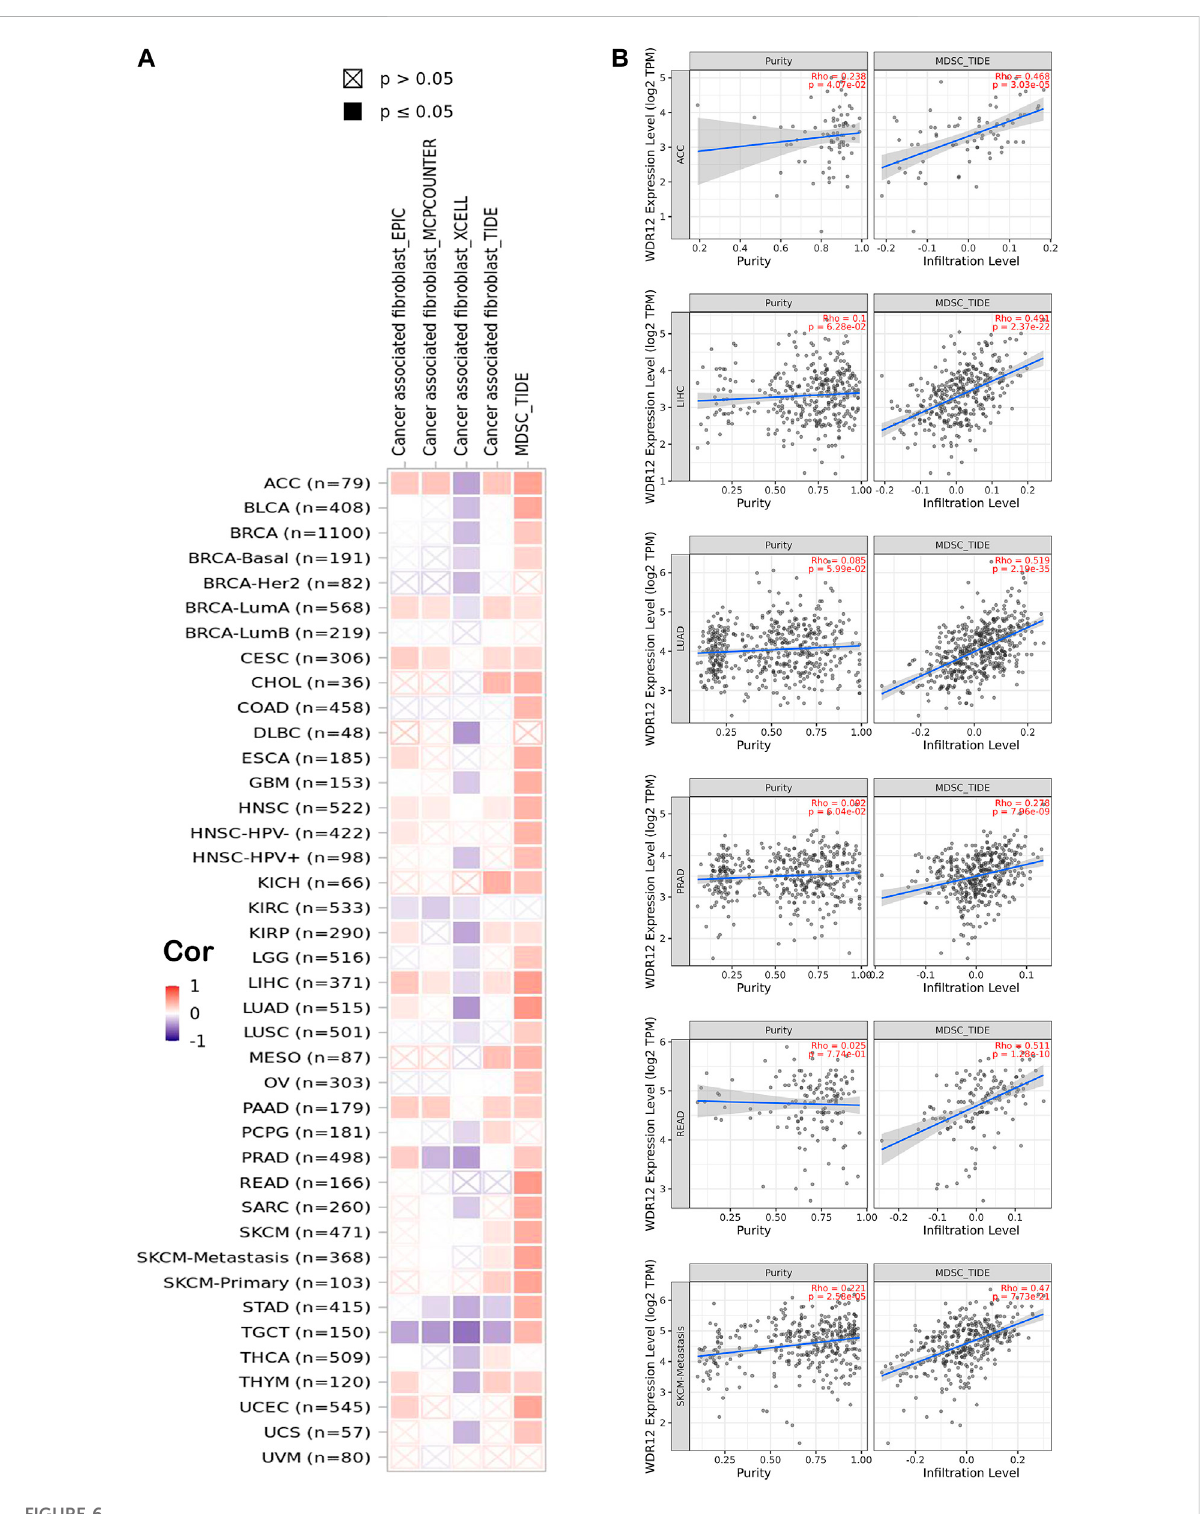
FIGURE 6 Correlation betweenWDR12expression leveland in fi ltrationof (A) myeloid-derivedsuppressorcells(MDSC) and; (B) Scatterplotsdemonstrate the correlation between the expression of WDR12 and the in fi ltration level of